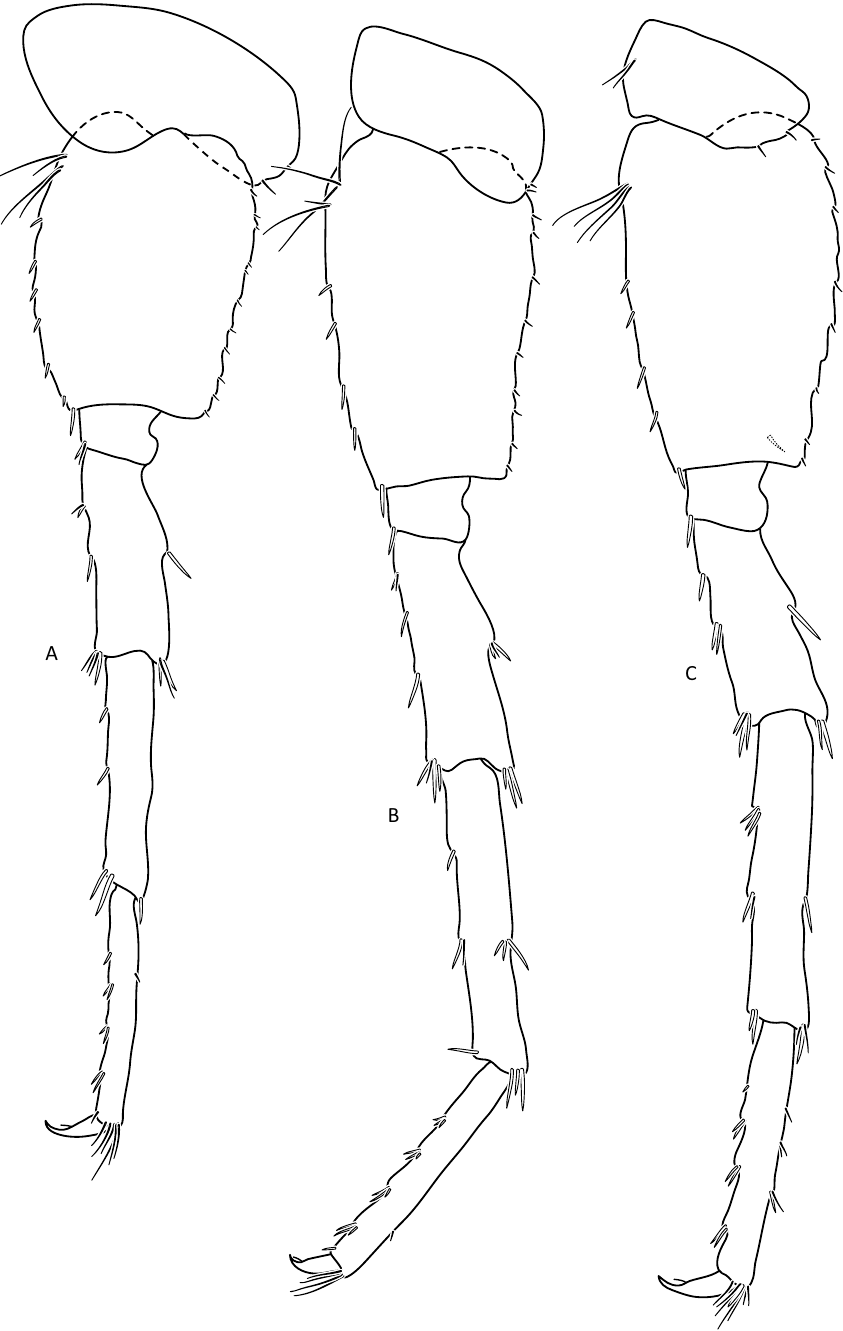
range of the Carpathians consisted of periglacial areas, not covered permanently by ice sheet. It could thus pro- vide suitable habitats for Gammarus sp. survival 55 (and references therein). It also seems that glaciations were the main factor behind demographic changes of the local lineages. These changes can be deduced in both studied species and their MOTUs. For example, in the Western Carpathians, MOTU G1 of G. tatrensis and G. stasiuki sp. nov. experienced a putative population bottlenecks at the end of the Pleistocene ( G. stasiuki sp. nov. only according to eBSP). These lineages are distributed at northern locations and, therefore, probably more affected